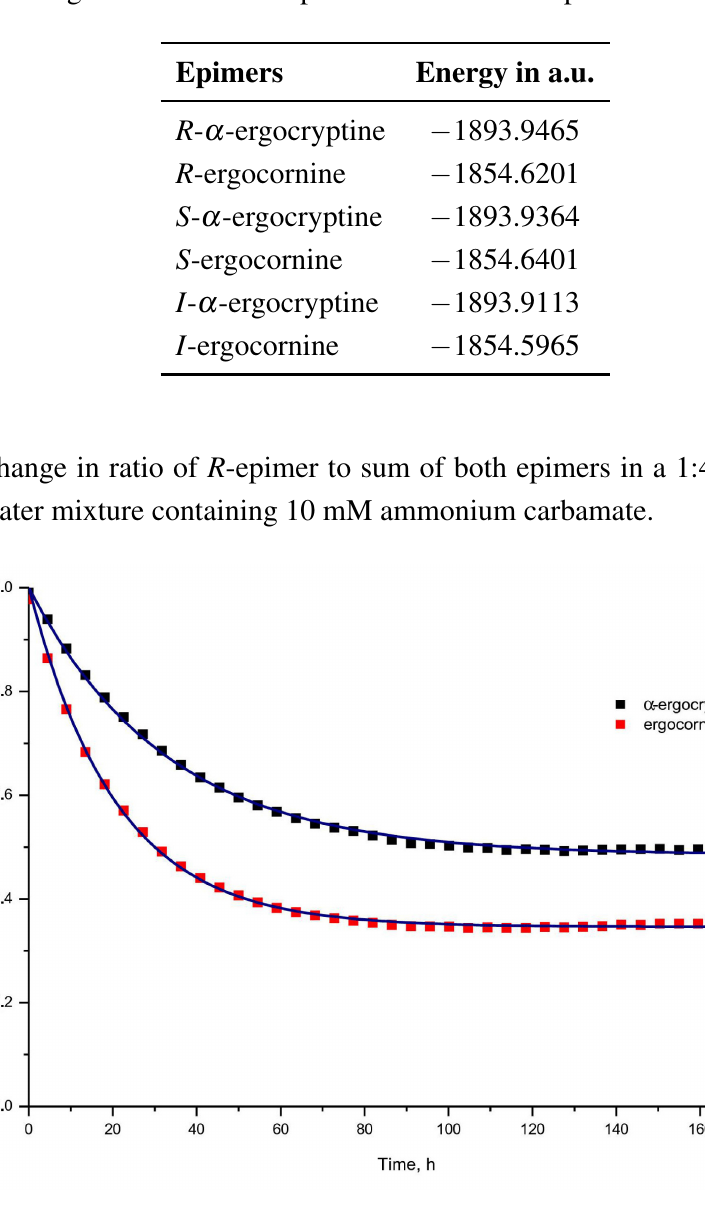
min of the epimers α -